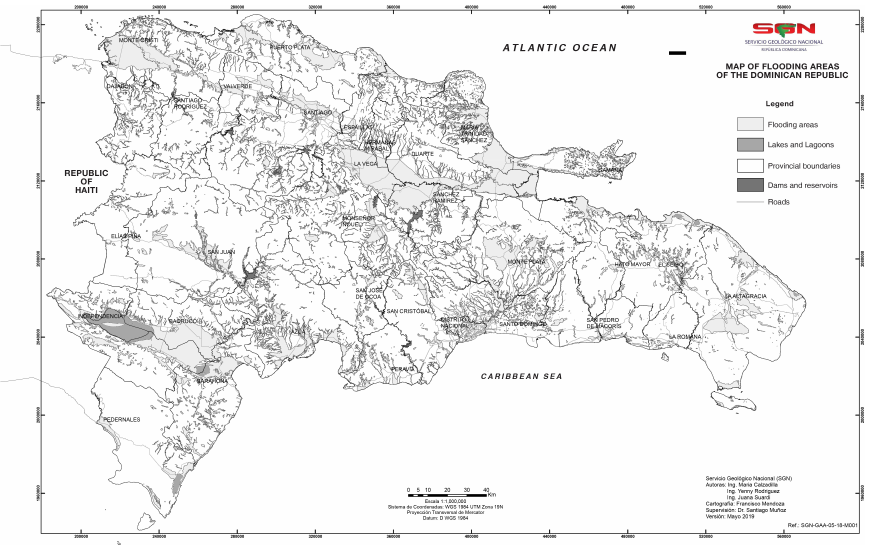
Figure 2. Map of flooding areas in the Dominican Republic (DR). Source: National Geological Survey, 2019.